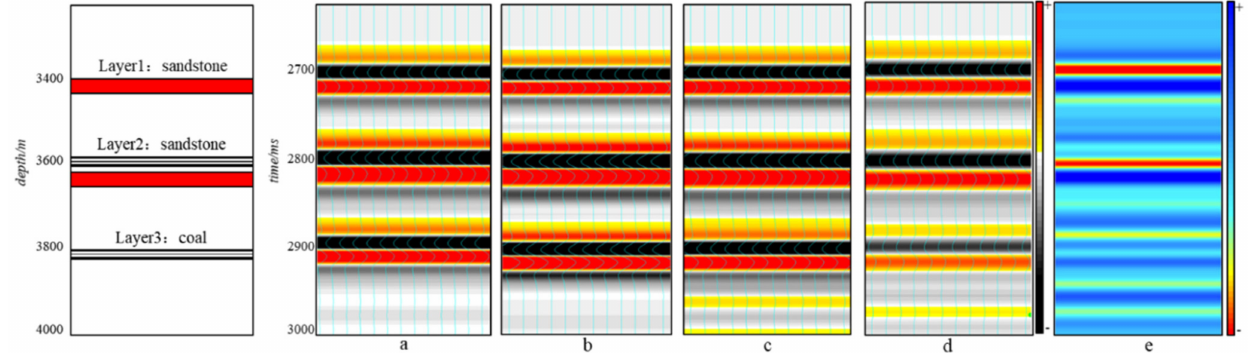
Figure 11. Seismic response of forward models with a sandstone–coal assemblage at different stack angles: ( a ) post-stack seismic analysis; ( b ) partial stacked seismic analysis 1–15 ◦ ; ( c ) partial stacked seismic analysis 15–30 ◦ ; ( d ) partial stacked seismic analysis 30–45 ◦ ; ( e ) P + G hydrocarbon detection